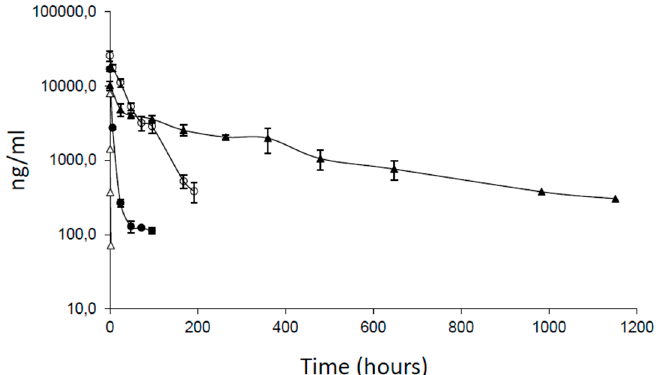
Figure 4. Plot of plasma concentrations of Trastuzumab and three related products obtained following single intravenous administration in Sprague-Dawley male rats (seven rats/group) of 2.0 mg/kg of Trastuzumab ( ▲ ), Trast Fab’ ( ∆ ), Trast F(ab’) 2 ( ● ) and Trast Fab’-Cys-PEG (2 × 20 kDa) ( ○ ). Blood samples for determination of Trastuzumab or Fab fragment concentration were withdrawn from tail vein at pre-fixed times (from 0 to 1200 h) after product injection. Table 4. Table of the main pharmacokinetic parameters calculated after i.v. administration of Trastuzumab, Trast F(ab’) 2 , Trast Fab’ and Trast Fab’-Cys-PEG (2 × 20 kDa) .